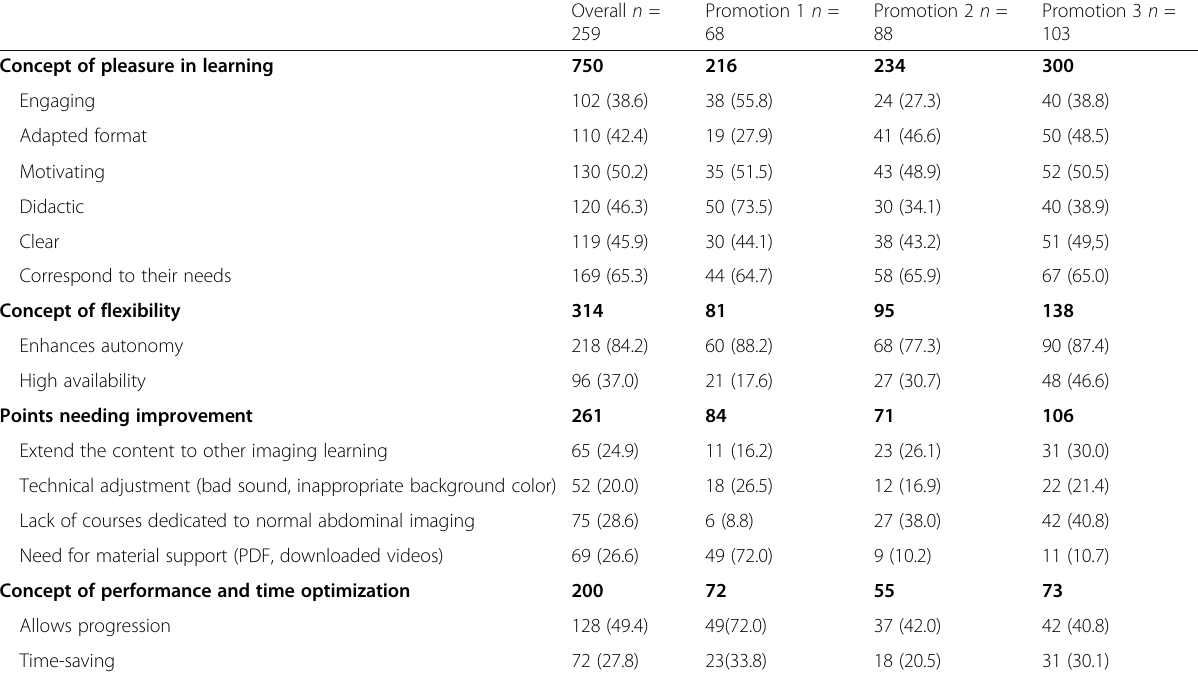
Overall n = Promotion 1 n = Promotion 2 n = 259 68 88